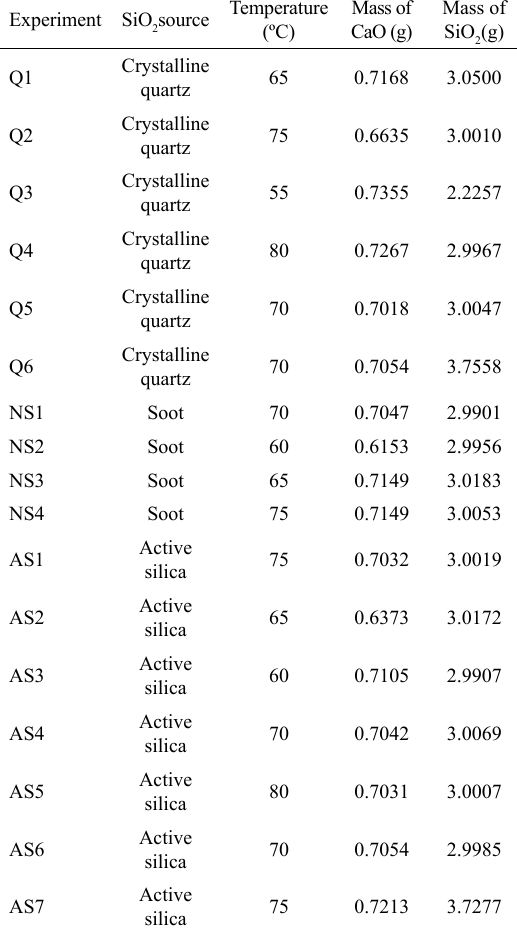
Table 2. Kinetic experiments performed.